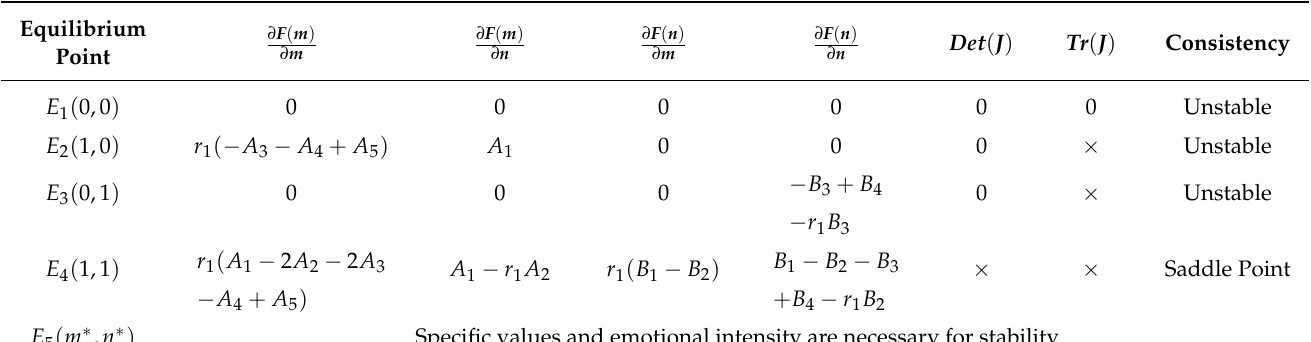
Table 6. Stability analysis of strategy portfolios under government regulators’ sentiment and energy consumers’ rationality scenarios.